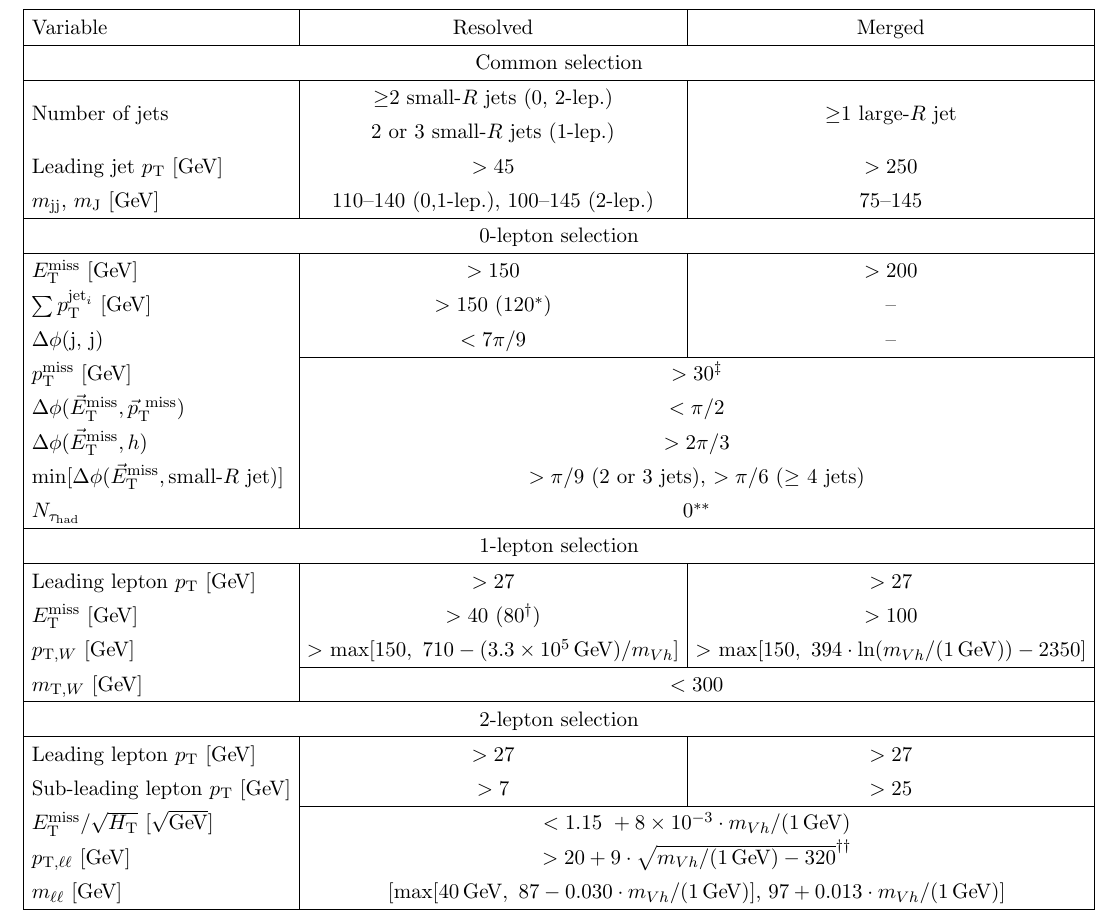
Table 2. Topological and kinematic selections for each channel and category as described in the text. ( (cid:3) ) Applies in the case of only two central jets. ( (cid:3)(cid:3) ) Tau veto only applied for the Z 0 =A search. ( y ) Tighter threshold (80 GeV) is used for the single-electron channel. ( yy ) Applied only for m 320 GeV. ( z ) Not applied in the resolved 2 and 3+ b -tag